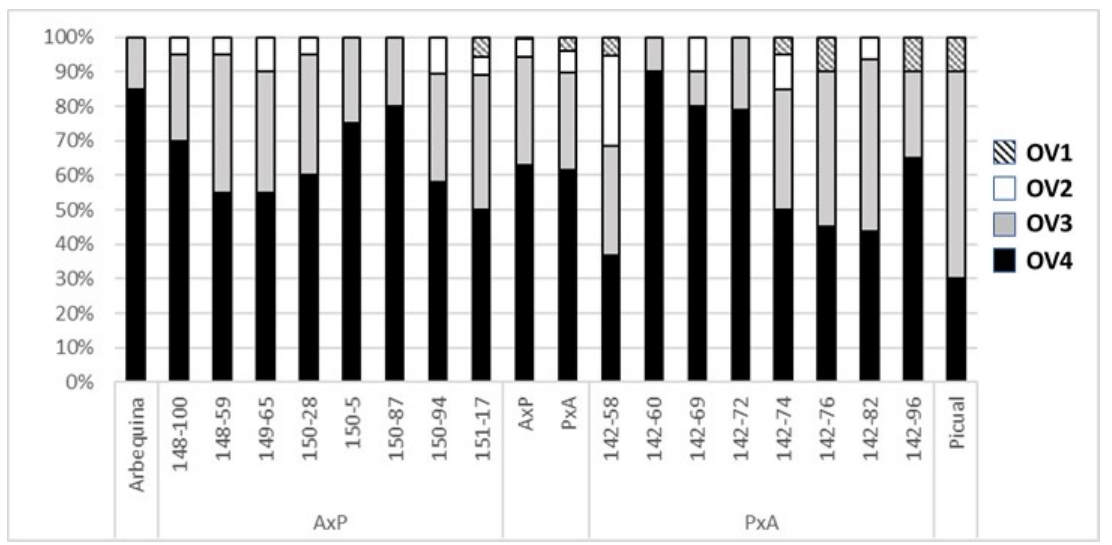
Figure 2. Ovary rating distribution (percentage) for each genotype, according to the number of normal, fully developed ovules of the four present in each ovary. Ovary categories are from OV1 (one fully developed ovule) to OV4 (four fully developed ovules). Distribution is shown for parent cultivars, ‘Arbequina’ and ‘Picual’, each individual progeny genotype, and means for all progenies of both crosses. Table 4. Average monthly values for daily average, maximum and minimum temperature, and cumulative rainfall for January to May in the two years (2013 and 2014) of the present